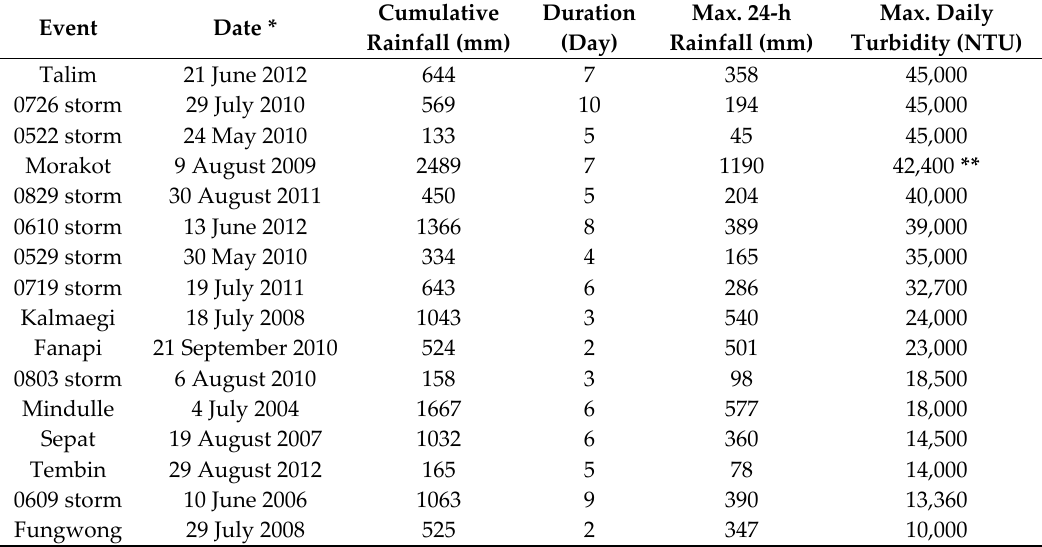
Table 3. Summary of the top 16 rainfall-induced high turbidity events in GRD during 2004–2012 (ranked by the maximum daily turbidity).